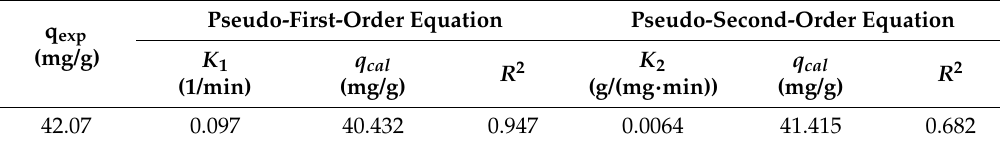
Figure 10. The adsorption kinetics of PRO onto ATP/Fe 3 O 4 /GO. Table 1. The kinetic parameters for PRO adsorption onto ATP/Fe 3 O 4 /GO.